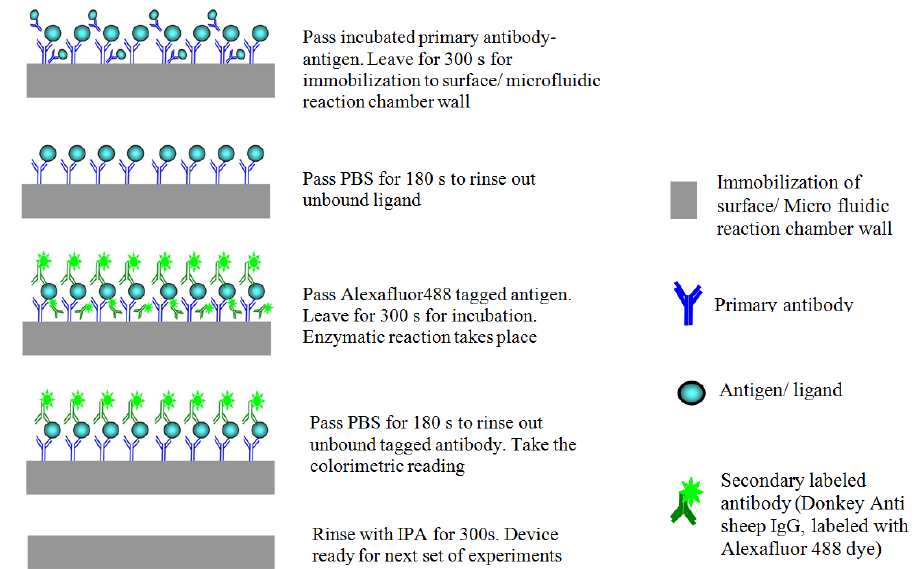
Figure 10. Process flow of immunoassay fluorescence detection for bio-optical detection of antigen.